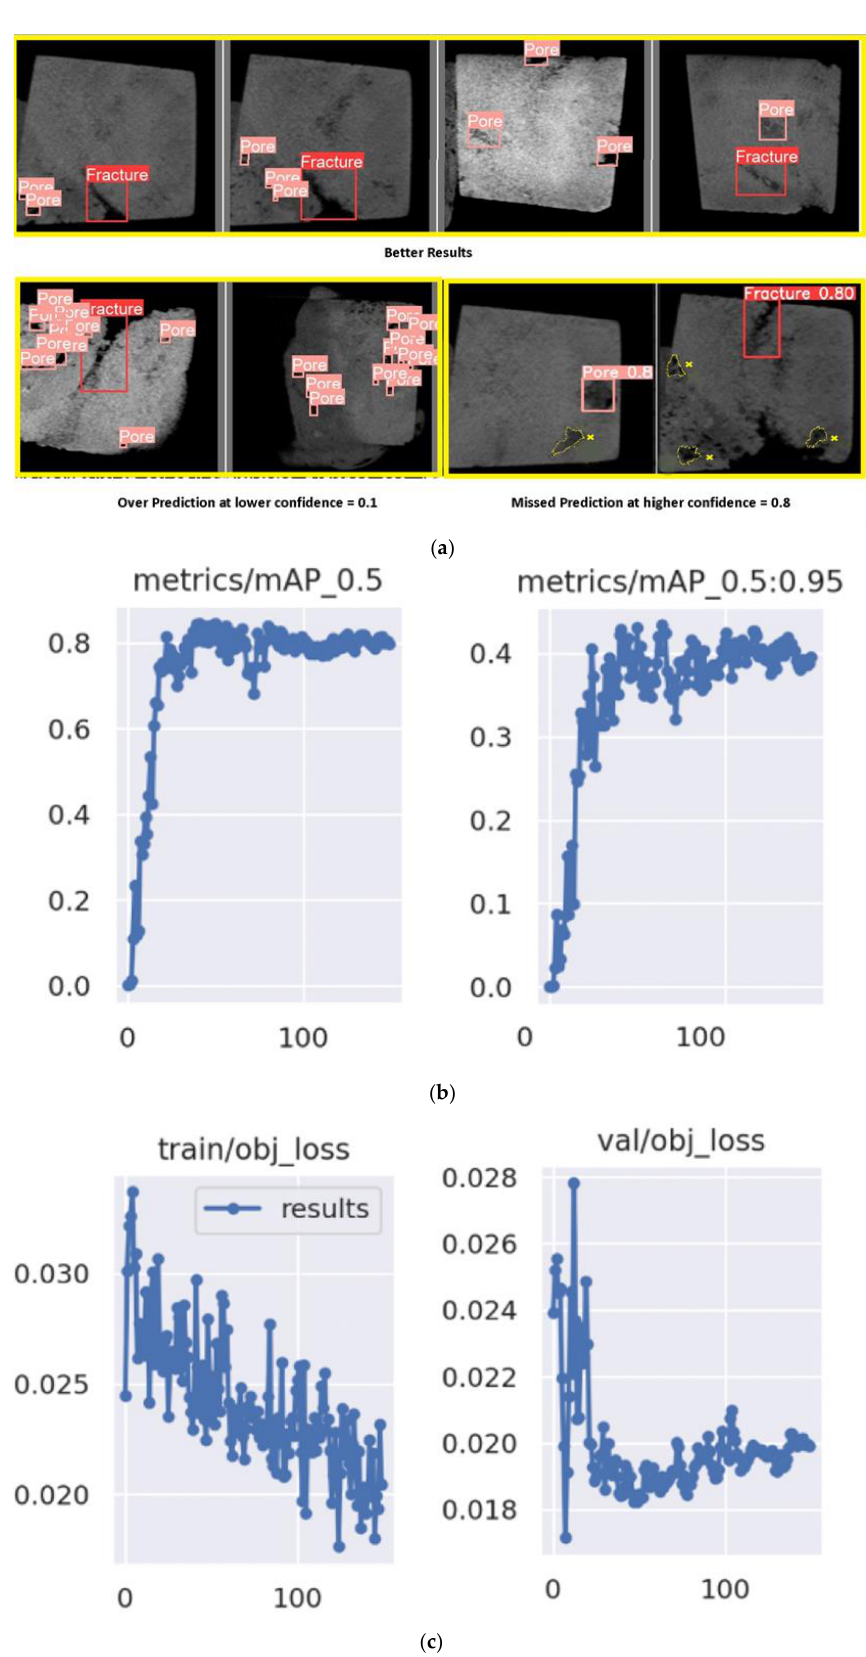
Figure 9. ( a ) Sample results with detected pores using Yolo v5 Deep-CNN. ( b ) mAP trend performance by confidence using Yolo v5 Deep-CNN. ( c ) Loss trend performance by confidence using Yolo v5 Deep-CNN.